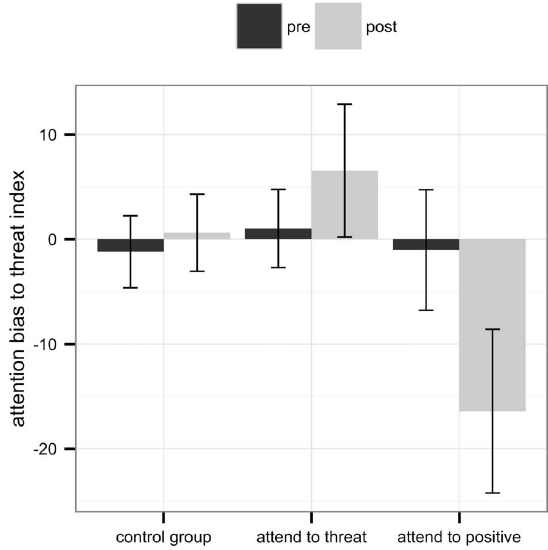
Figure 3. Attention bias to threat indices at pre- and at post-